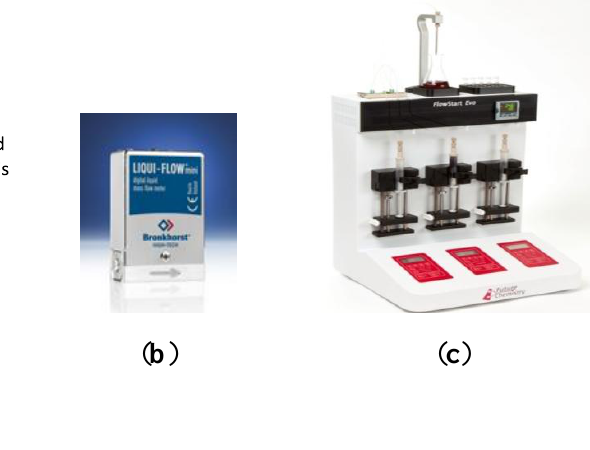
Figure 1. Schematic drawing of the microfluidic setup ( a ) including ( b ) the Liquiflow mini and ( c ) the FlowStart Evo